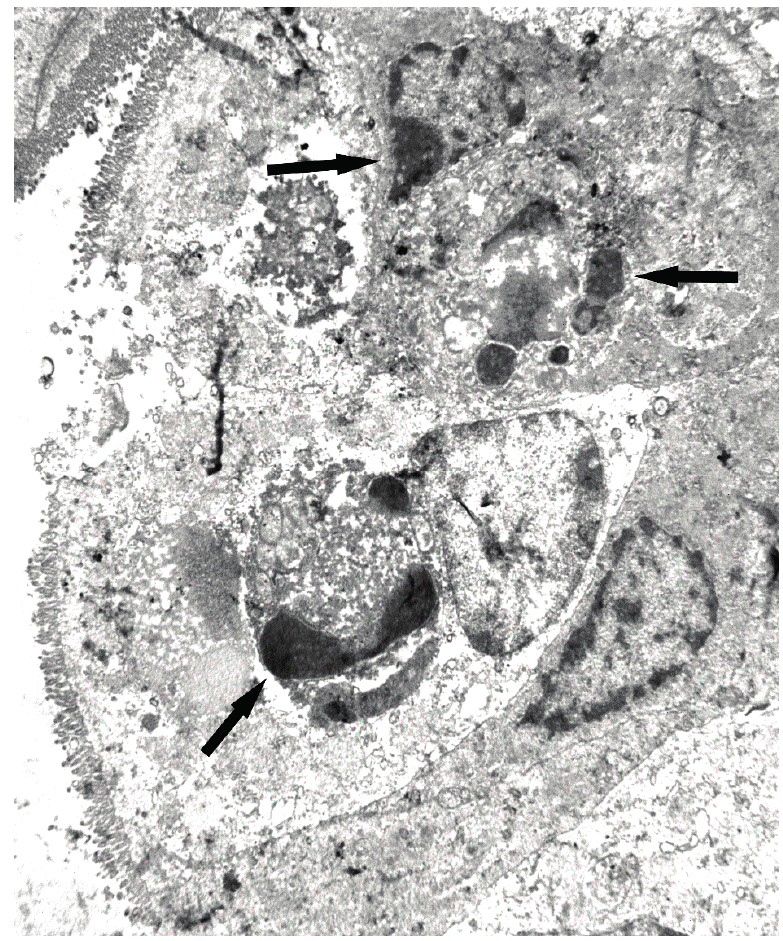
Figure 2. Electron micrograph of Lieberkühn’s crypt of the small intestine in a mouse 6 h after injection with 16 mg/kg nigrin b. Dead cells showing apoptotic bodies can be seen at the bottom of the crypt (arrows).